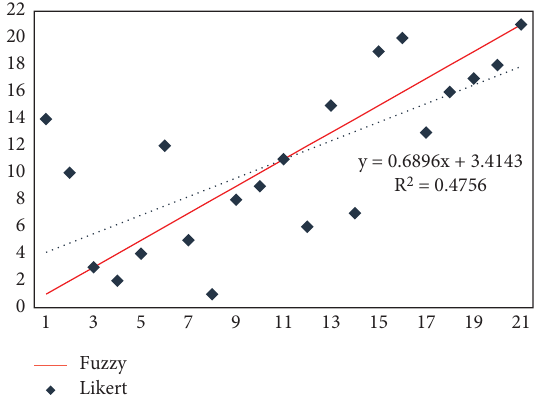
Figure 3: FEGRA ranking: comparison of alternative data modelling method.